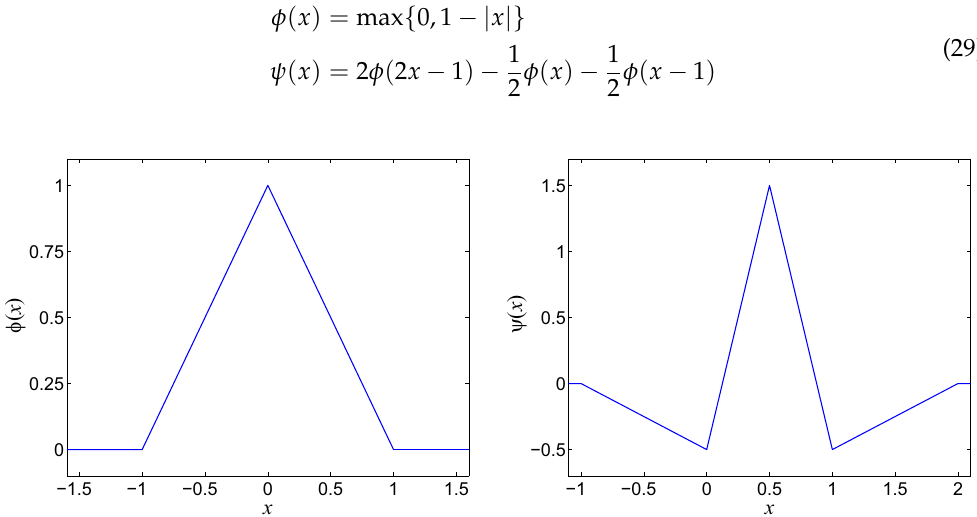
Figure 5. Father wavelet φ ( x ) and mother wavelet ψ ( x ) for the linear interpolating transform.